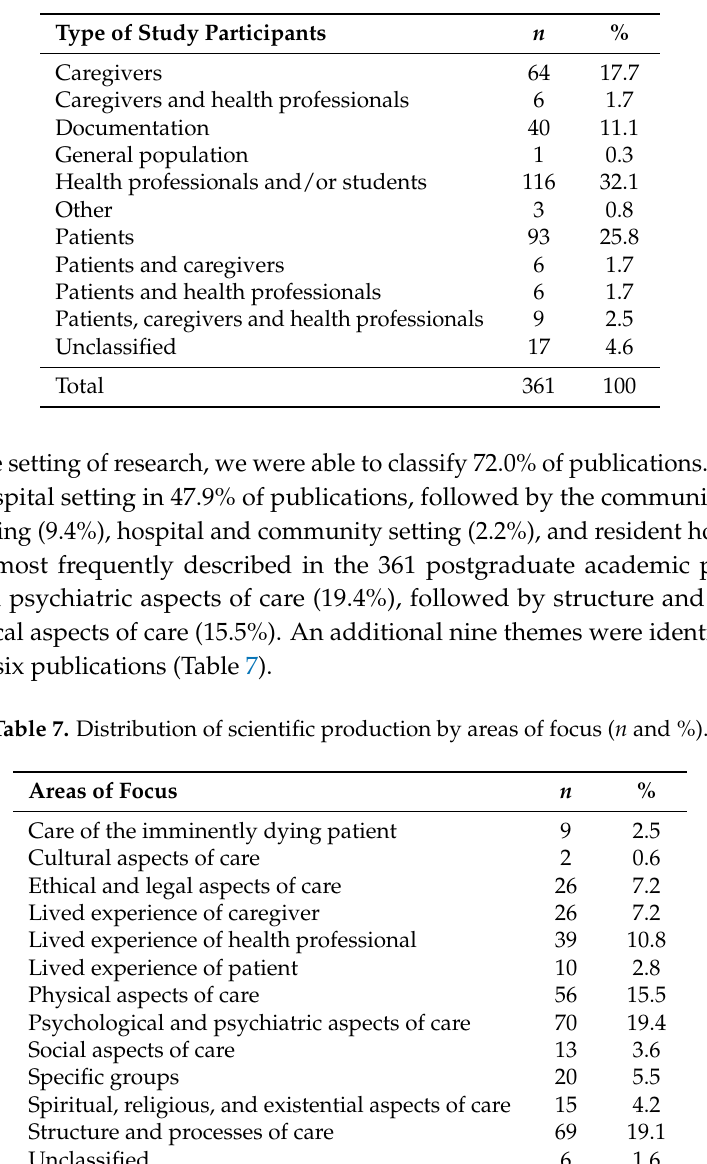
Table 6. Distribution of scientific production by type of study participants ( n and %).